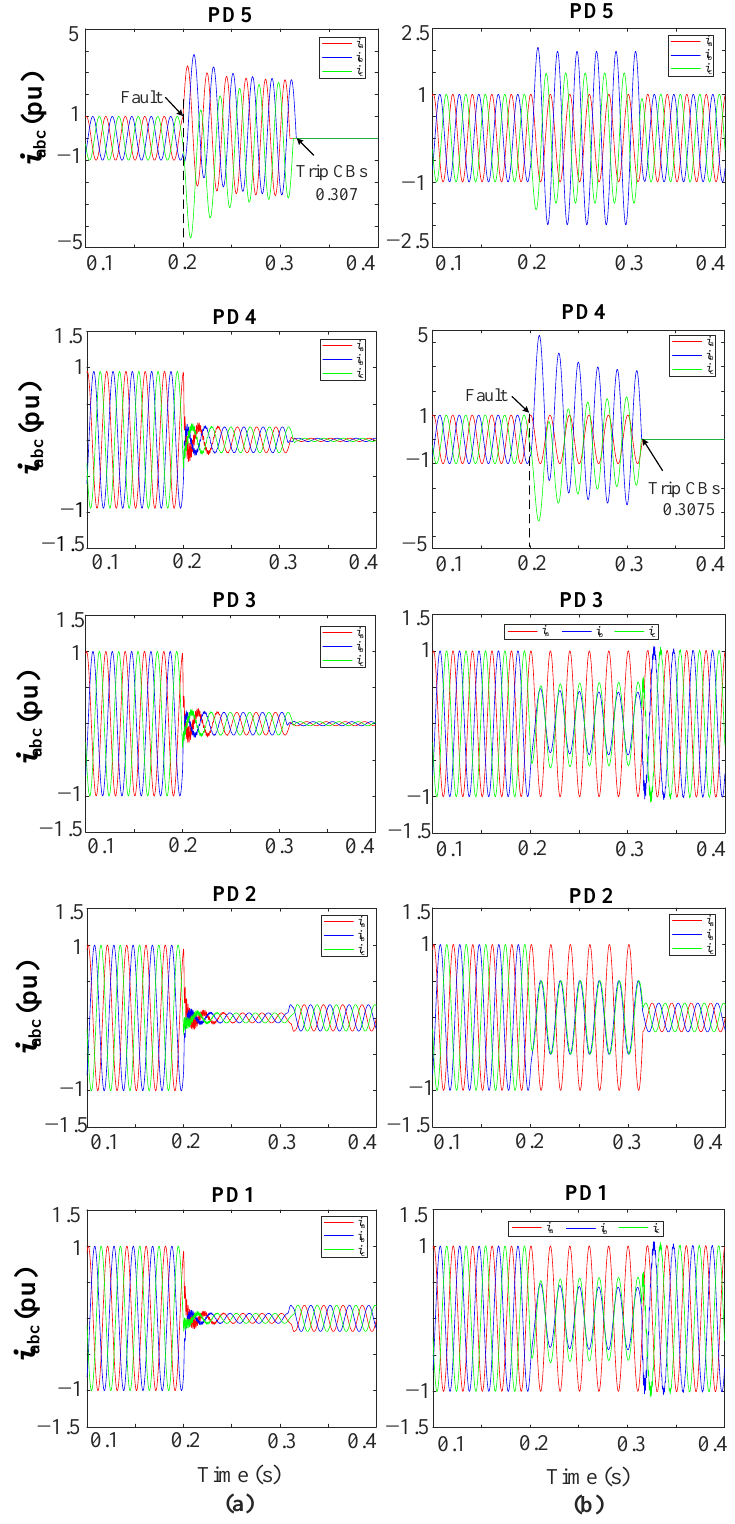
Figure 10. 𝑖 𝑎𝑏𝑐 currents for the grid ( a ) during a 3PH fault at L3, ( b ) during a 2PH fault, phases b and c , at DL2.